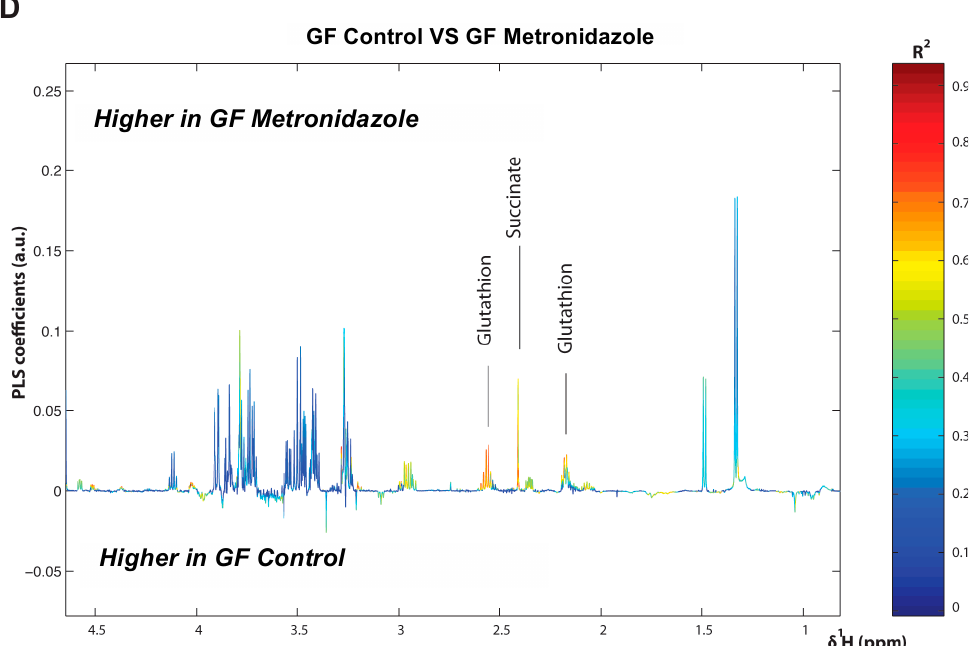
Figure 6. Liver metabolite profiles of SPF and GF antibiotic treatment groups. ( A ) A summary table showing all of the parameters used for the generation of orthogonal projection on latent structure-discriminant analysis (O-PLS-DA) plots and quality of the results of O-PLS-DA generated for all the SPF and GF models. The number of samples used for the respective groups is indicated in brackets together with the number of predictive and orthogonal components used. R2X, R2Y, and Q2Y values for each O-PLS-DA generated are shown. Significant p -values that were generated using student t -test are represented in red. ( B ) O-PLS-DA correlation coefficients (r2) maps that tested to be significant by student t -test are presented. R2 map discrimination between polar liver metabolite extracted from SPF Control (C) vs. SPF Ampicillin (A), SPF Control (C) vs. SPF Vancomycin (V) treated group, and SPF Control (C) vs. SPF AMNV treated group. Peaks in the positive upward direction indicate metabolites that were more abundant in the treated groups, while metabolites that were more abundant in control groups are presented as peaks in the negative downward direction. ( C ) Boxplots of lactate and succinate for antibiotic-treated groups, as indicated. One-way ANOVA analysis was performed on NMR lactate’s signature peak at position 1.32 ppm, as well as succinate with its signature peak at 2.41 ppm. Groups with statistically significant changes as compared to the SPF control are represented by * for p -value < 0.05, ** for p -value < 0.01, and *** for p -value < 0.001. Two outliers, one from SPF ampicillin treatment and one from GF non-treated control, were removed before the analysis. SPF control and respective antibiotic treated groups are represented by C (Control), A (Ampicillin), M (Metronidazole), N (Neomycin), V (Vancomycin) and AMNV (combination of all four antibiotics) while GF control and Vamcomycin-treated mice are represented by GFC and GFV respectively. ( D ) O-PLS-DA correlation coefficients (r2) map tested significant by student t -test is presented. R2 map discrimination between polar liver metabolite extracted from GF control vs. GF Metronidazole. One outlier sample from GF control treatment was removed. Peaks in the positive upward direction indicate metabolites that were more abundant in treated groups, while metabolites that were more abundant in control groups are presented as peaks in the negative downward direction.